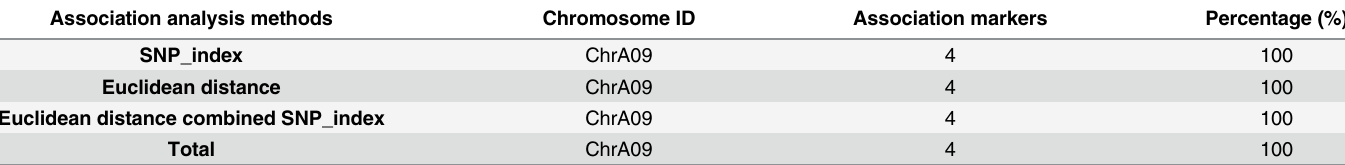
Table 5. Number distribution of association markers on the chromosome by the SNP_index, Euclidean distance and Euclidean distance combined SNP index association analysis methods. Association analysis